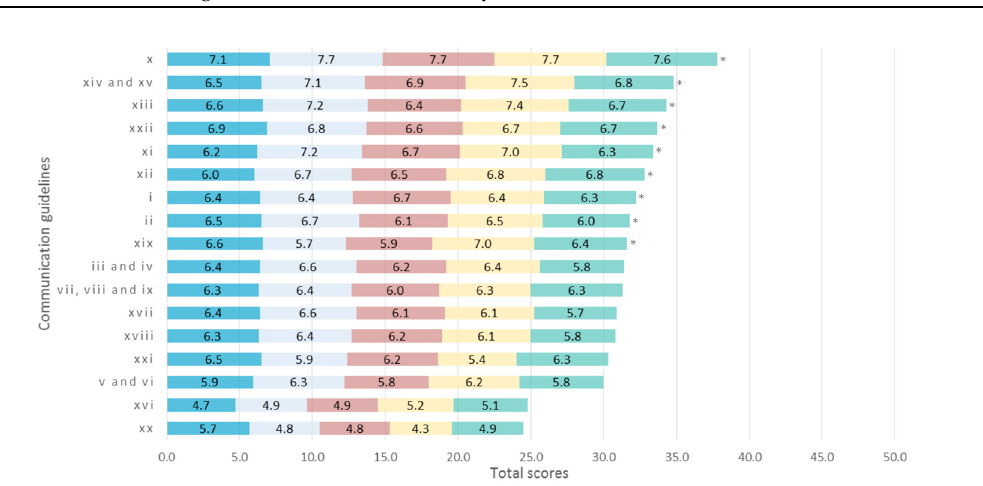
Figure 3. Stakeholder evaluation of communication guidelines based on the five quality criteria ( n = 10). The vertical axis indicates the numbering of communication guidelines as in Table 2. The horizontal axis denotes the score that each (group of) item(s) received. The total scores range from 5 to 50, but the axis is set to start at 0.0 in order to show the correct proportions of rating for the quality evaluation criteria. The numbers inside the five sections of each bar correspond with the average scores on the criteria. The total scores do not differ significantly among items based on Friedman non-parametric test ( p -value = 0.080). The asterisks (*) indicate the items selected for the Delphi round 2. The items of policy recommendations and communication guidelines with the highest mean scores were selected to enter the Delphi round 2. All (groups of) items had an IQR ≤ 4 except for one communication guideline item ( item x with IQR = 4.25), but this item was included because it received the highest rating. 3.2.2. Delphi Round 2 The results of Delphi round 2 were presented in Supplementary material S5 using two- dimensional graphs. Supplementary Material S6 shows a summary of the evaluation task based on average scores for relevance, feasibility, and their correlation coefficient (r s ), which specifies the relationship between the scores on relevance and feasibility. These two criteria are significantly and positively correlated for all items, except for communication guideline items x and xii . For most of the items, scores for relevance and feasibility were similar among the different stakeholder groups. Table 4 summarizes the ranking and statistical tests of all items. Policy recommendation item u “Focus on ways to improve motivation such as creating information needs and increasing the interest in healthy eating” and communication guideline item x “Keep communication simple and clear, avoid overly complex supporting information that uses scientific and/or regulatory jargon, while at the same time limiting propositions that are not fully scientifically sound in product positioning and communication strategies” were consistently at the top of the ranking. There were some changes in rankings from the Delphi round 1 to round 2; however, the changes could not be meaningfully interpreted, because some items were evaluated in groups in the Delphi round 1 (in order to shorten the very long list), but the grouped items were then divided and evaluated as individual items in the Delphi round 2 (as only a number of items have been selected, there was room for evaluating items individually to provide more accurate insight). As a result, some items shared the same ranking as a group in the Delphi round 1, but the individual items had different rankings in the Delphi round 2. Regarding communication guidelines, item xiii “Use innovative ways to communicate the importance of healthy eating, aiming to change the perception of negative association between healthiness and tastiness” shifted from the third place in round 1 to the first place in rounds 2 and 3. The biggest changes in ranking were observed for items xxii and ii ; they shifted from the fourth to the eighth rank and from the eighth to the fourth, respectively.